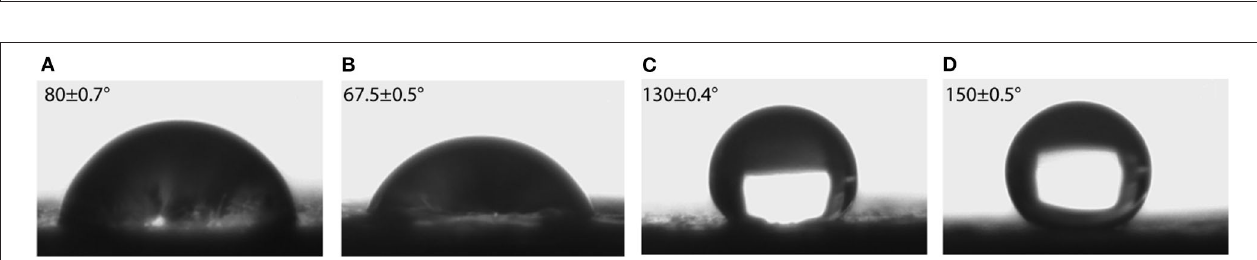
FIGURE 7 | Contact angle on steel and Gr-coated steel treated by sintering to 500 ◦ C. (A) Bare steel, (B) Steel + Gr without heating, (C) steel + Gr 500 ◦ C, (D) Steel + Gr 500 ◦ C + THFS.